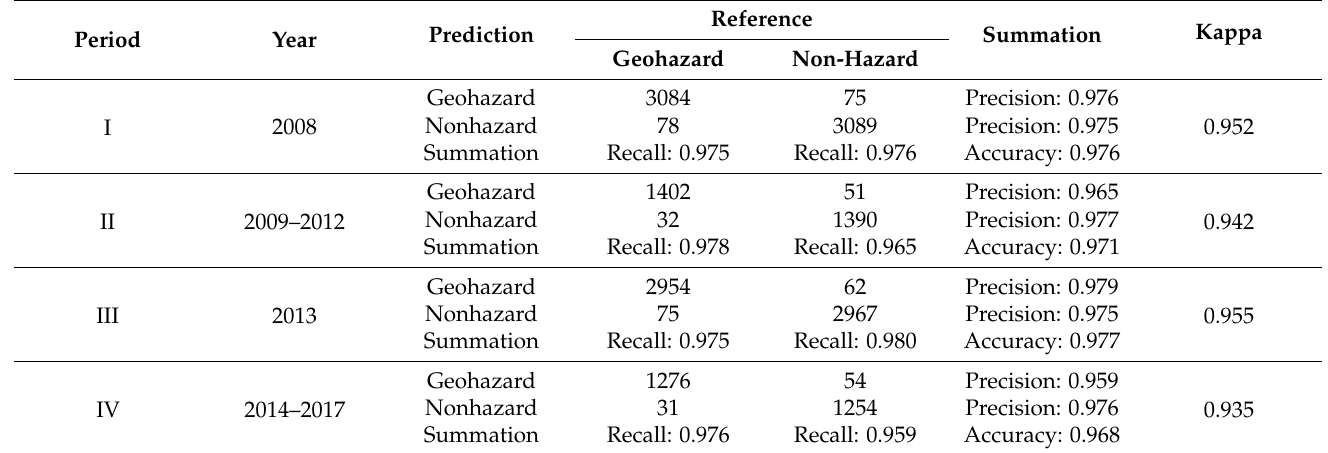
Table 4. Confusion matrix of different RF